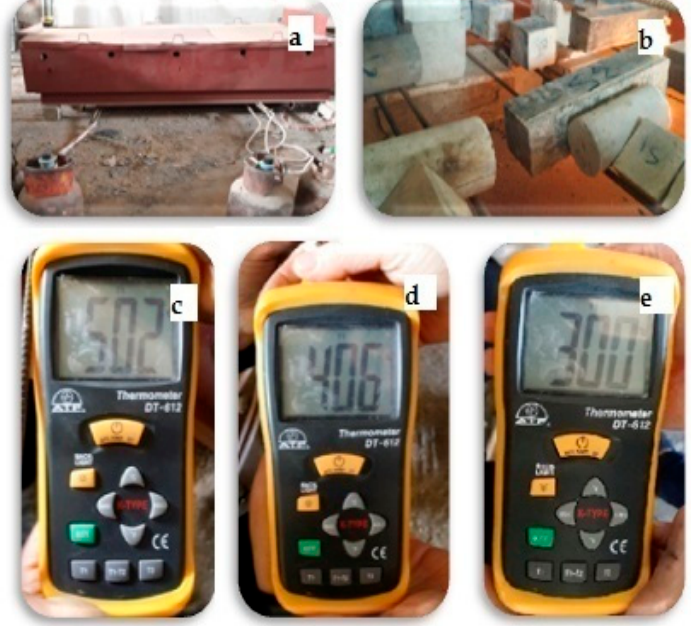
Figure 1. Burning process: ( a ) Burning furnace setup; ( b ) Samples inside the furnace; ( c ) Thermocouple device at 500 °C; ( d ) Thermocouple device at 400 °C; ( e ) Thermocouple device at 300 °C.